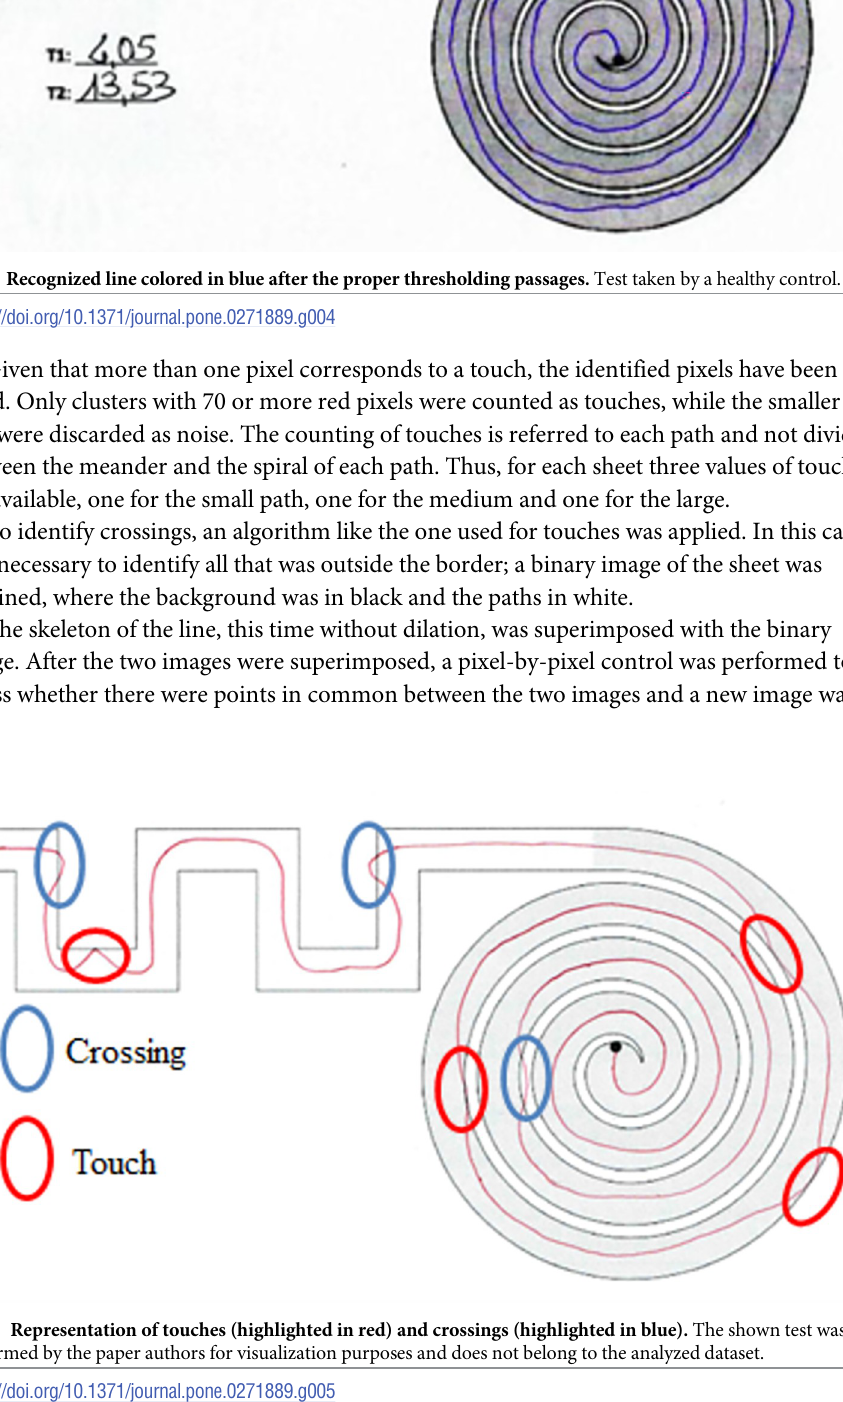
Fig 5. Representation of touches (highlighted in red) and crossings (highlighted in blue). The shown test was performed by the paper authors for visualization purposes and does not belong to the analyzed dataset.